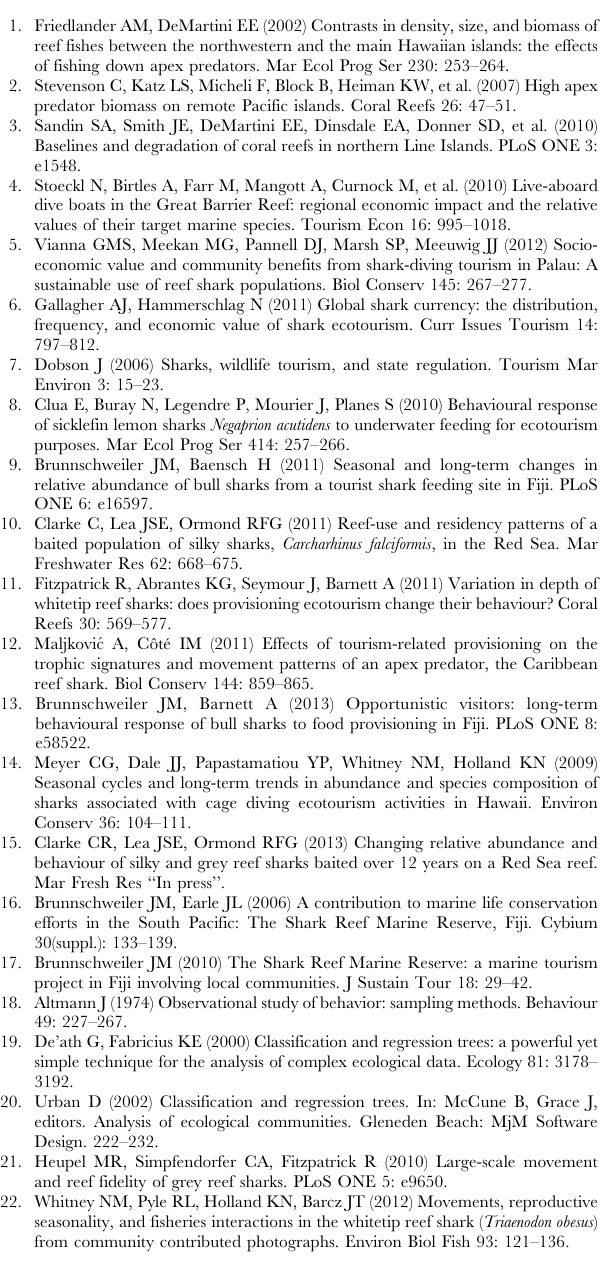
Table S1 Number of sampling days per month per